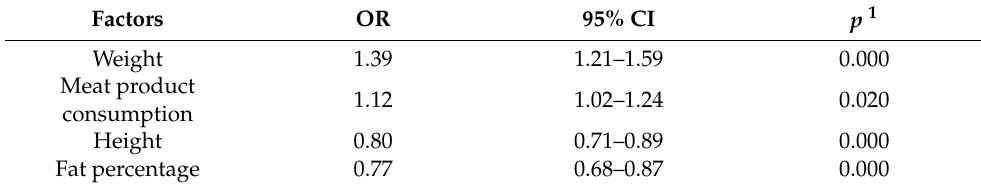
Table 6. Odds ratios (ORs) and 95% confidence intervals (CIs) for PA relative to the factors